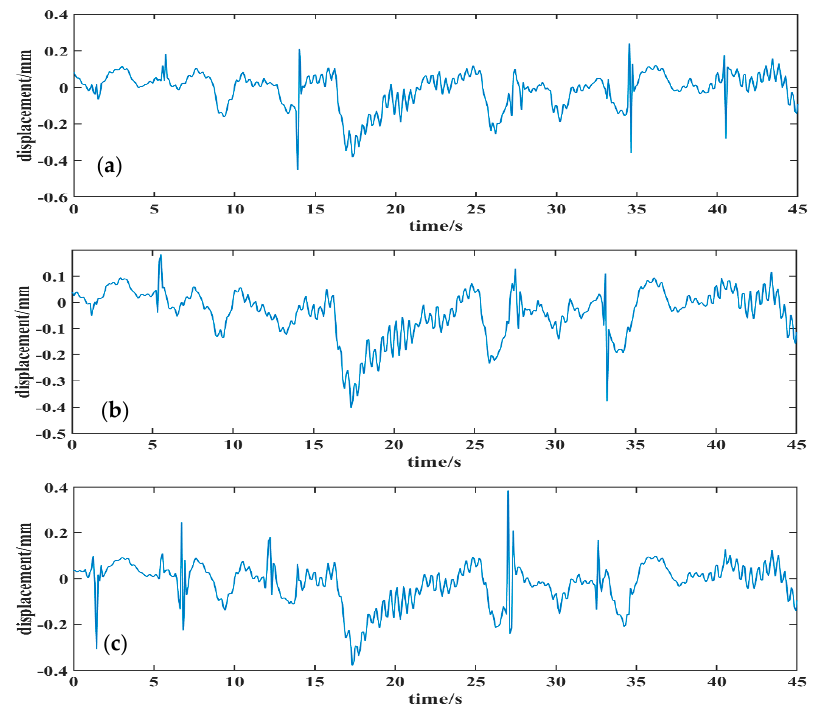
Figure 7. Three time-series displacements of the mid-span point and two adjacent points. ( a ) Observed signal X1, ( b ) observed signal X2, and ( c ) observed signal X3.